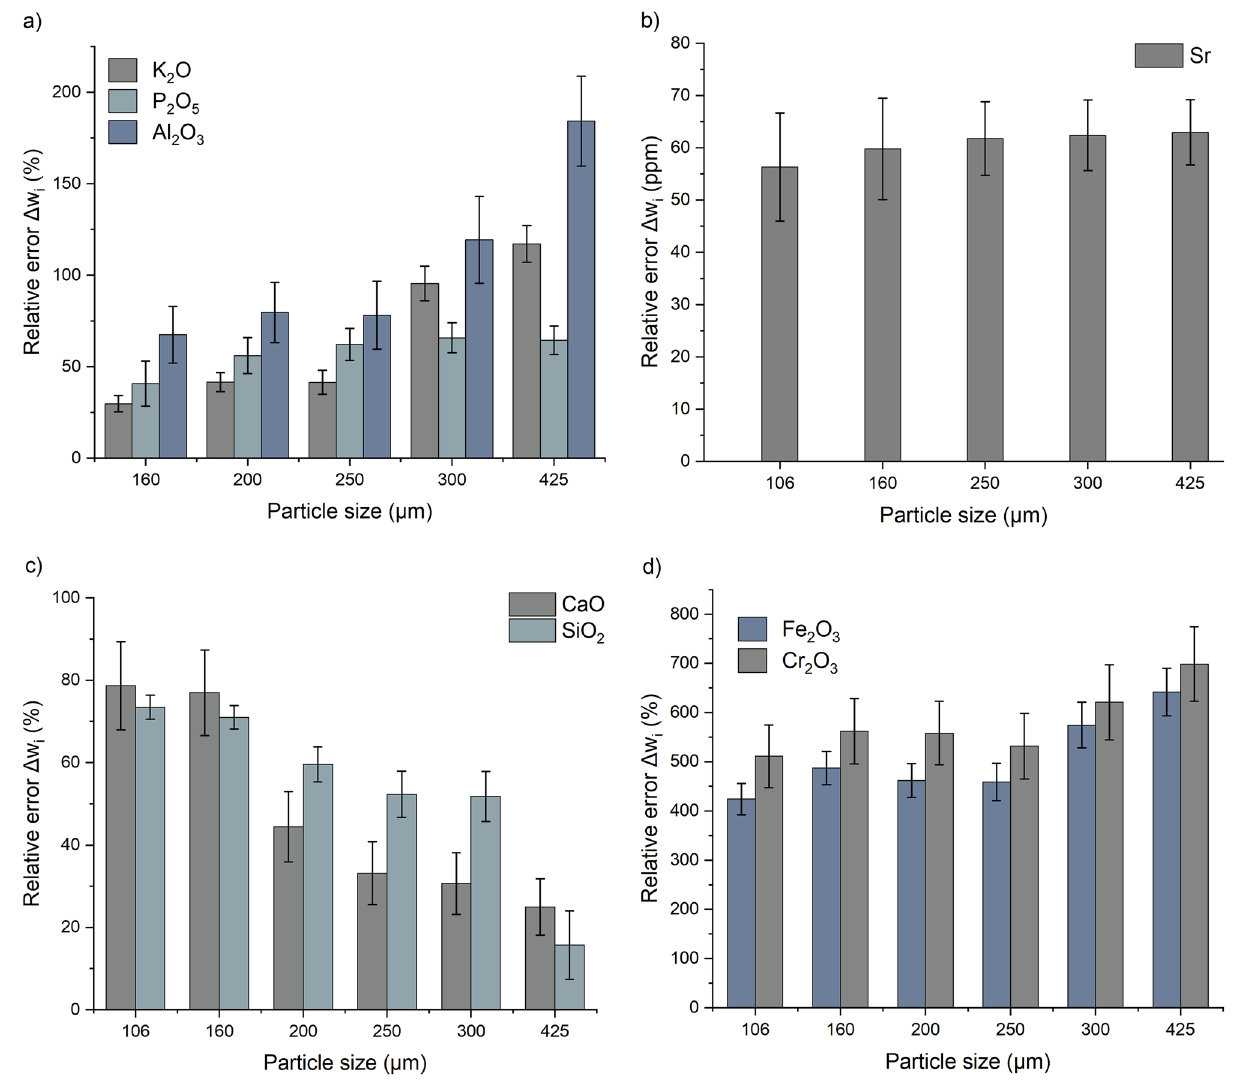
Figure 3. The relative error of XRF measurements as a function of particle size. ( a ) P 2 O 5 , Al 2 O 3 and K 2 O, ( b ) Sr, ( c ) CaO and SiO 2 , ( d ) Fe 2 O 3 and Cr 2 O 3